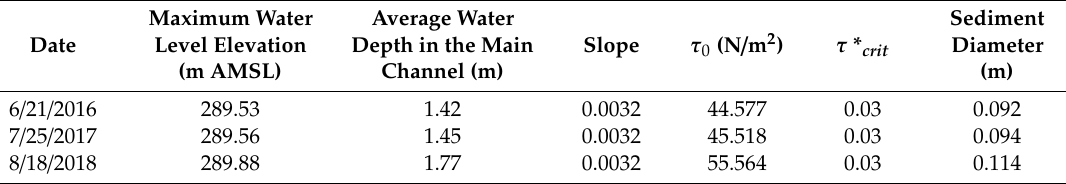
Table 2. Maximum particle size moved after breakup—Sagavanirktok River at Happy Valley (DSS3).